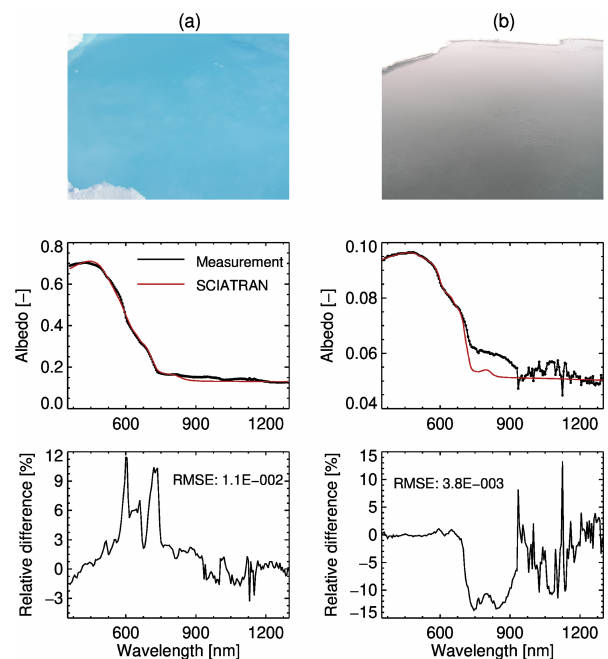
Figure 7. Comparisons of the spectral albedo for the light-blue (a) and dark (b) melt ponds corresponding to Figs. 6a and 8a in Malinka et al. (2018). The upper row shows pictures of the measurement scenes, the middle row shows the measured and simulated spectral albedos, and the lower row shows relative differences between the SCIATRAN simulations and campaign